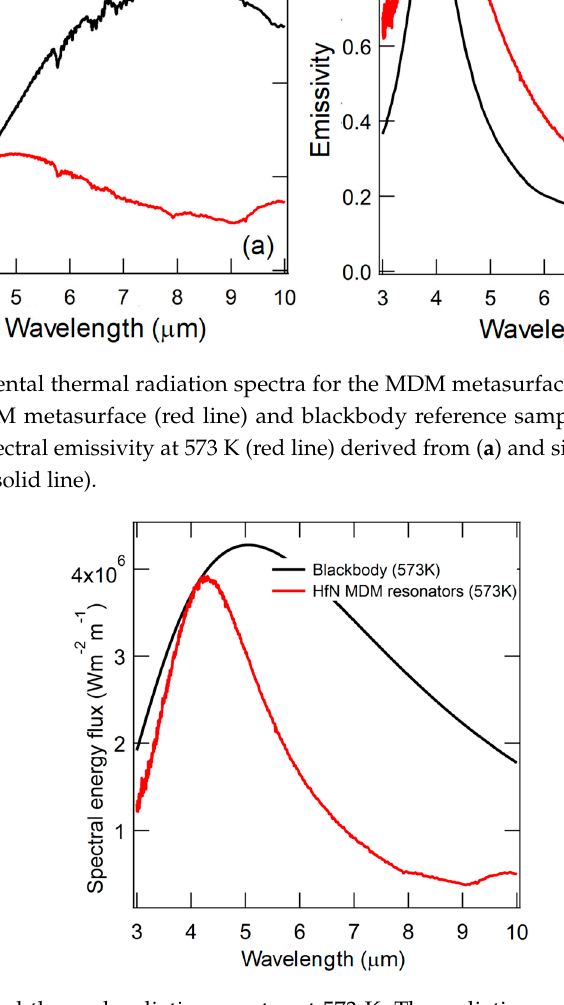
Figure 14. Calculated thermal radiation spectra at 573 K: The radiation spectrum from the MDM metasurface (red line) is calculated from the measured emissivity shown in Figure 13b. The theoretical blackbody radiation spectrum (Equation (1)) at 573 K (solid line) is plotted for reference.